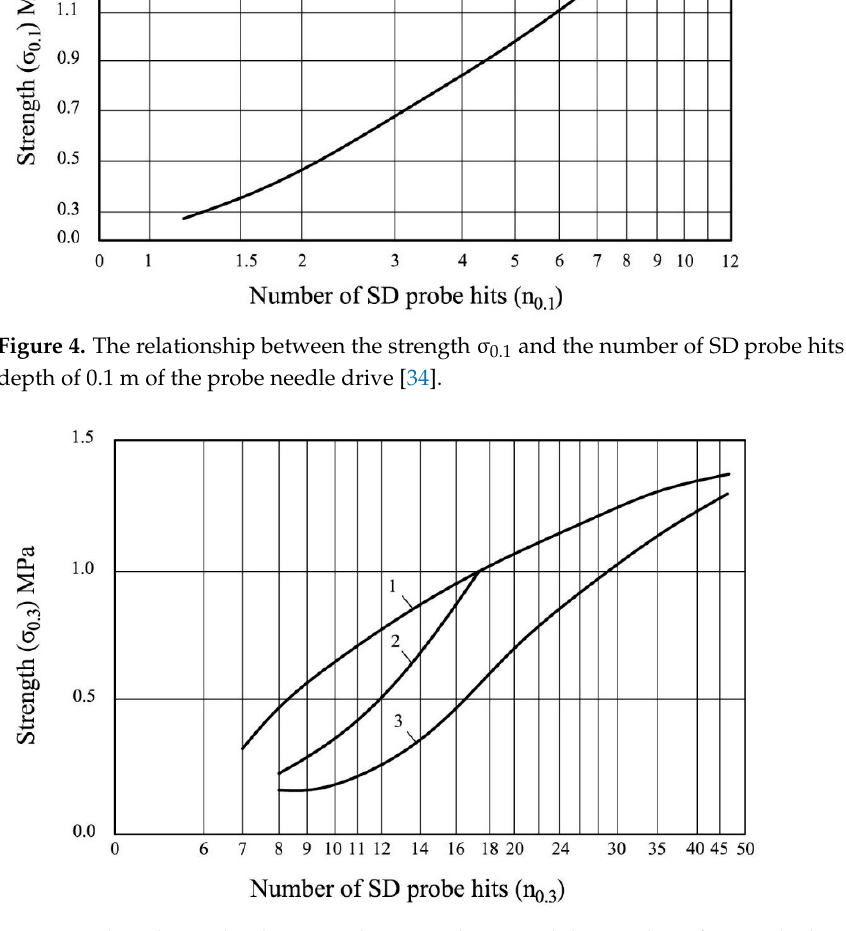
Figure 5. The relationship between the strength σ 0.3 and the number of SD probe hits (n 0.3 ) per the depth of 0.3 m of the probe needle drive; 1—sands, silty sands, clay sands; 2—silty sands, sandy clays; 3—mold, soils close to the optimal [34].